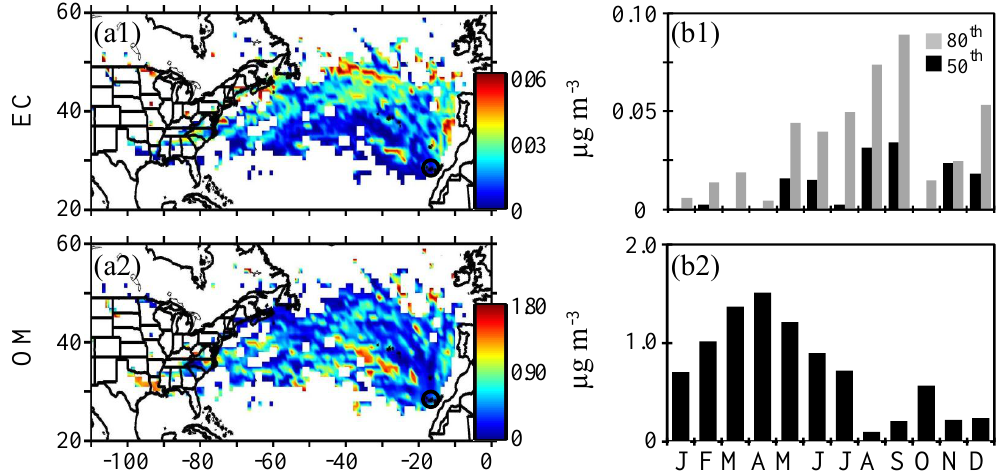
Figure 6. (a) Median Concentration At Receptor (MCAR) plots and (b) monthly median distribution for elemental carbon (EC) and organic matter (OM) for the study period. Percentiles 50 and 80 are shown for EC. The MCAR plots maximum concentration tick label includes concentration higher than this upper limit. The location of Izaña is highlighted (black